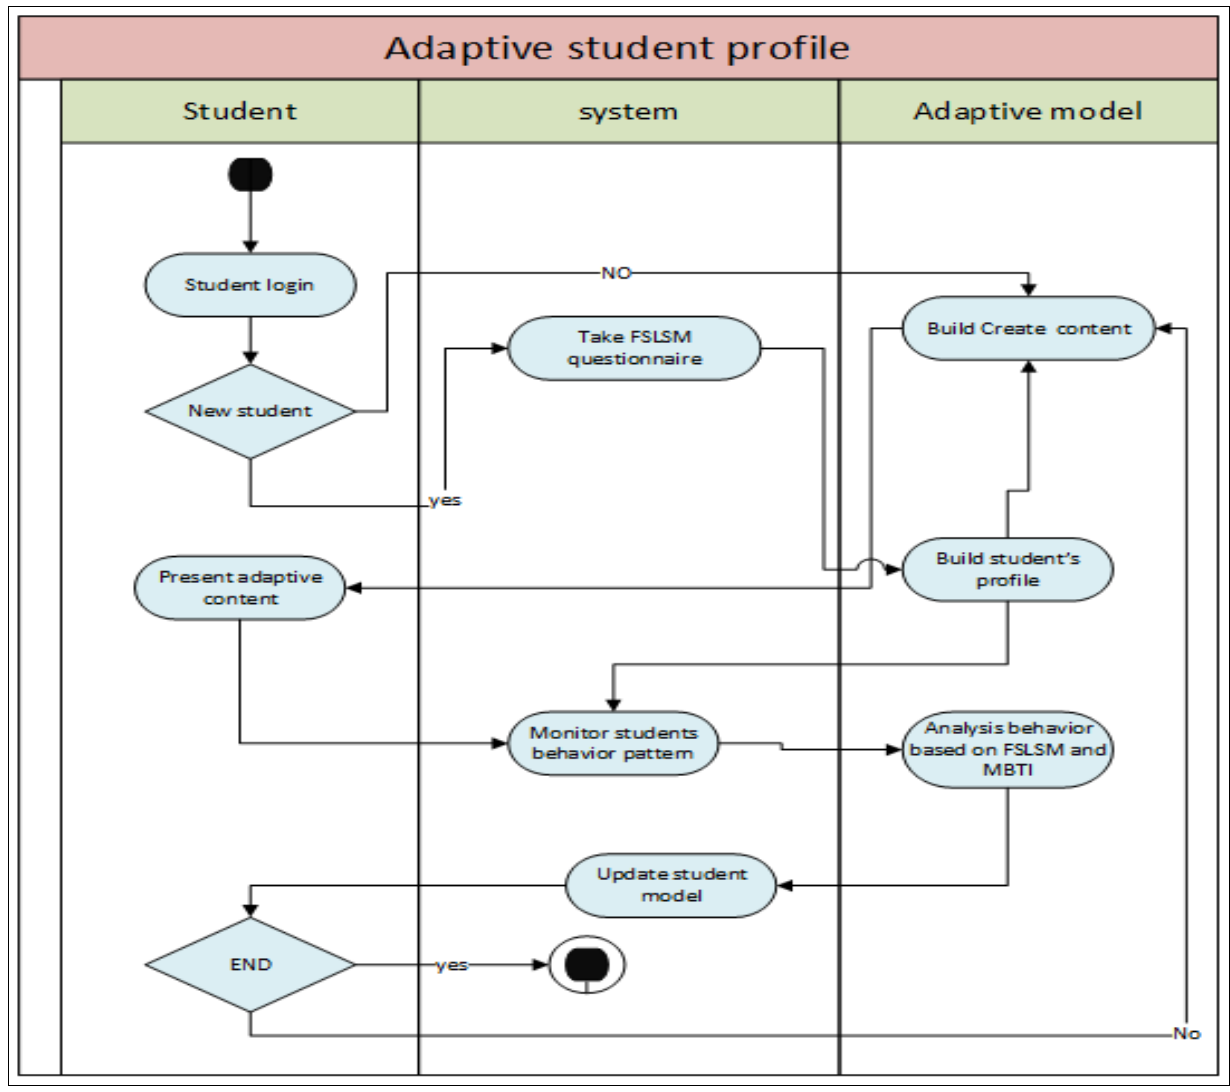
Figure 8. Proposed student profile